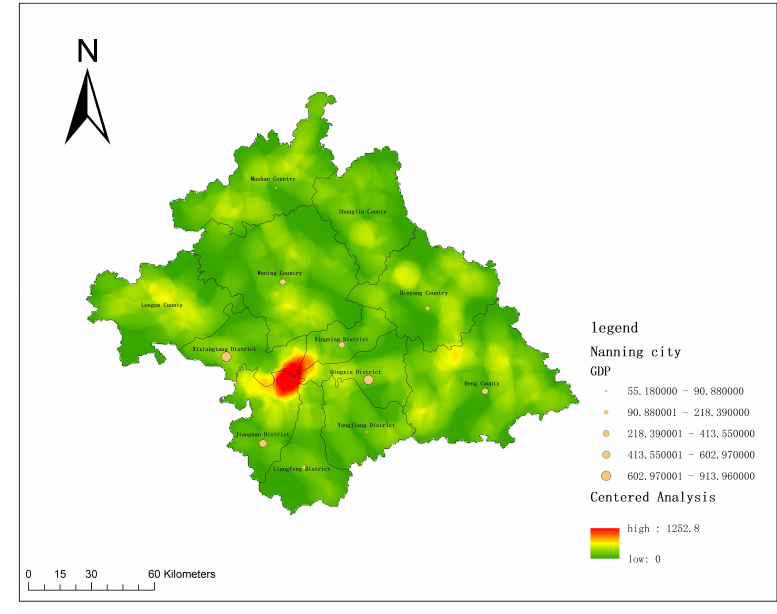
Figure 3. Analysis of road centrality in Nanning city